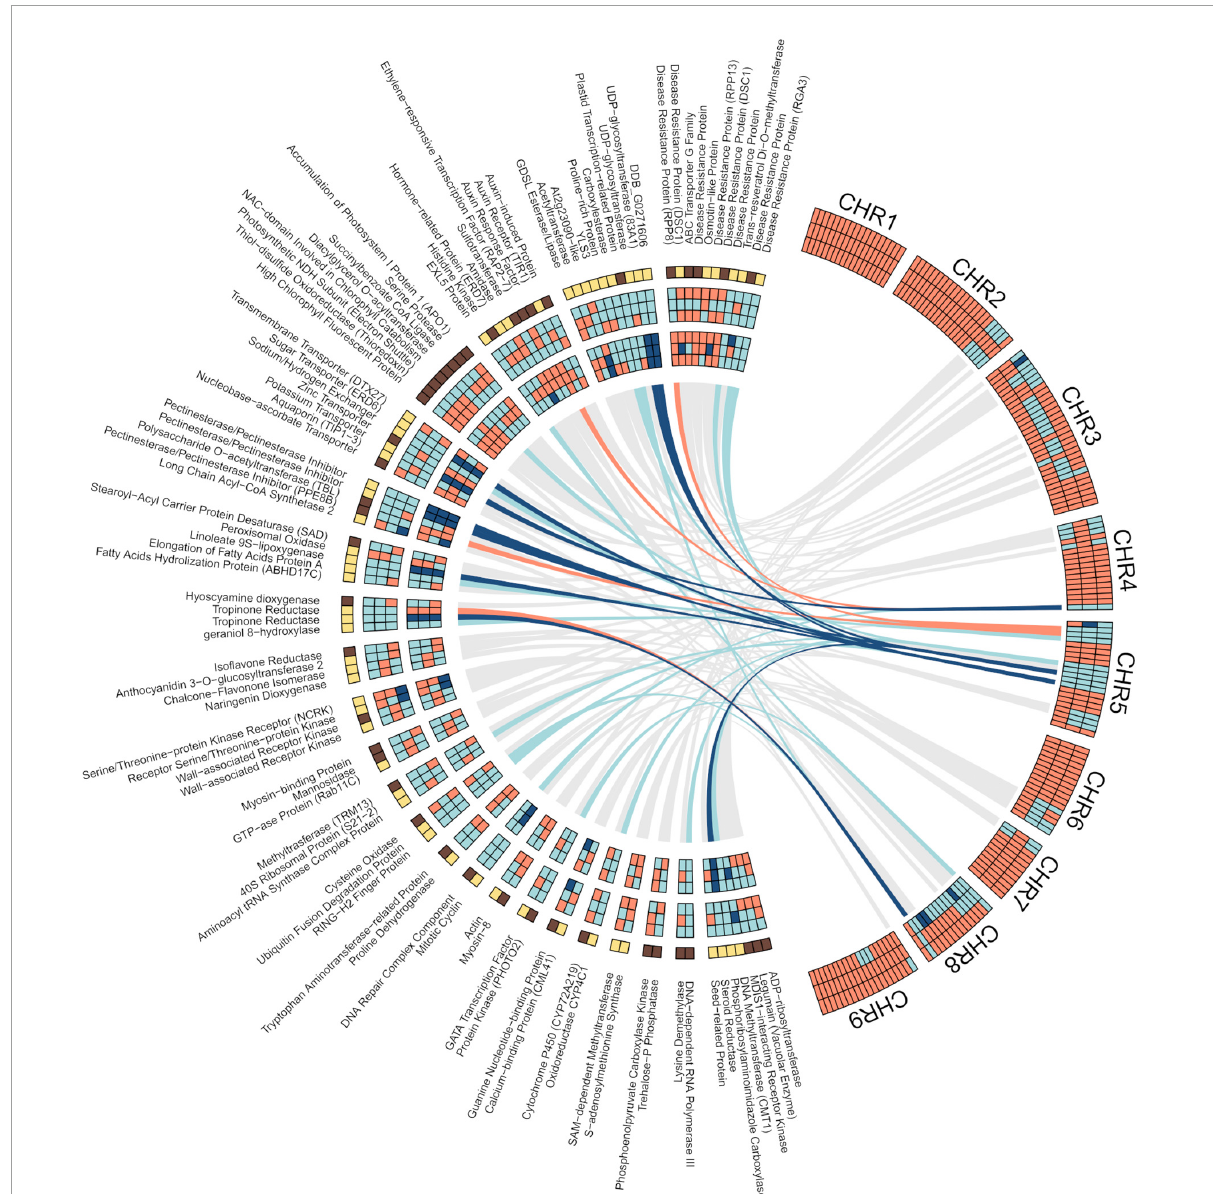
FIGURE4 Shared DEGs in the pulp of developing fruitlets of segregants, S1, S2, and S3, as related to SCM. Right Circos. Chromosome admixture structure of the three segregants. From top to bottom, S3 (first row), S2 (second row), and S1 (third row); orange: mandarin/mandarin; light blue: pummelo/mandarin; dark blue: pummelo/pummelo. Left Circos. First row (from top to bottom): gene expression; yellow: up; dark brown: down. Second, third, and fourth rows: gene genotype; orange: mandarin/mandarin; light blue: pummelo/mandarin; dark blue: pummelo/pummelo. Fifth, six, and seventh rows: allele expression; orange: mandarin/mandarin; light blue: pummelo/mandarin; dark blue: pummelo/pummelo. Ribbons connect each gene which its physical position in the reference genome. DEGs with the same genotype in the three segregants are connected by colored ribbons; orange: mandarin/mandarin; light blue: pummelo/mandarin; dark blue: pummelo/pummelo. All other DEGs are connected to their respective positions by gray ribbons. DEGs at the outside of the Circos are clustered by categories ( Supplementary Table 5 ) and ordered by the number of members of the category, from top to bottom: Plant defense (11); Uncharacterized process (10); Hormonal regulation (9); Chloroplast (8); Transport (7); Cell wall (5); Lipid and fatty acids (5); Alkaloids (4); Flavonoids (4); Receptors, kinases, transduction (4); Trafficking, vesicles (3); Translation (3); Ubiquitination (3); Aminoacid metabolism (2); Cell division (2); Cytoeskeleton (2); Light signaling (2); Membranes, RE, signaling (2); Redox (2); S -adenosylmethionine metabolism (2); Sugar metabolism (2); and Transcription (2). A final cluster included those categories with a single member: Seed, embryo development (1); Organ development, differentiation (1); Nucleobases (1); Nucleic acids processing (1); Gametophyte and fertilization (1); Cell death (1); and Abiotic stress (1). Results were plotted in R language and environment (R Core Team, 2021), using packages included in Tidyverse collection (Wickham et al., 2019) and circlize (Gu et al.,